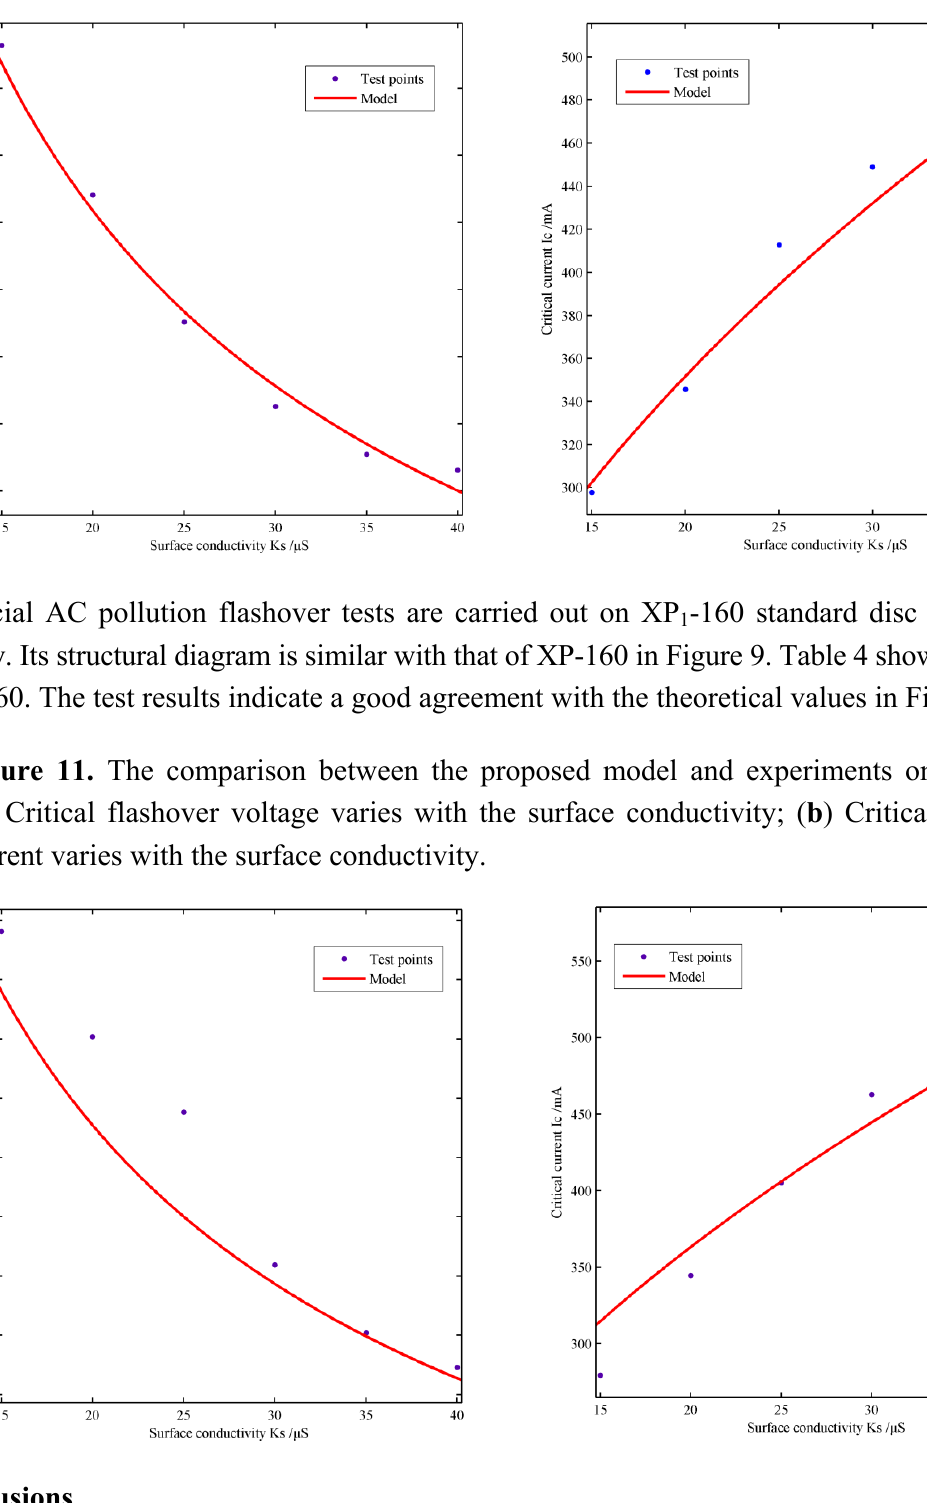
Figure 10. The comparison between the proposed model and experiments on XP-160. ( a ) Critical flashover voltage varies with the surface conductivity; ( b ) Critical flashover current varies with the surface conductivity.